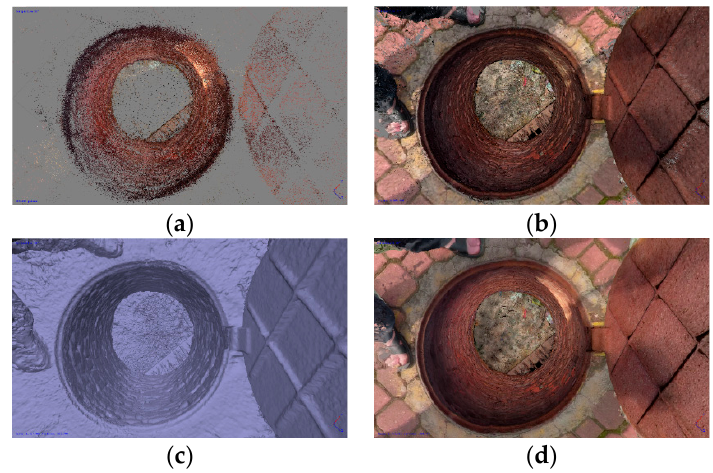
Figure 5. Reconstruction result of scene 1: sparse point cloud ( a ), dense point cloud ( b ), solid model ( c ), and textured model ( d ).